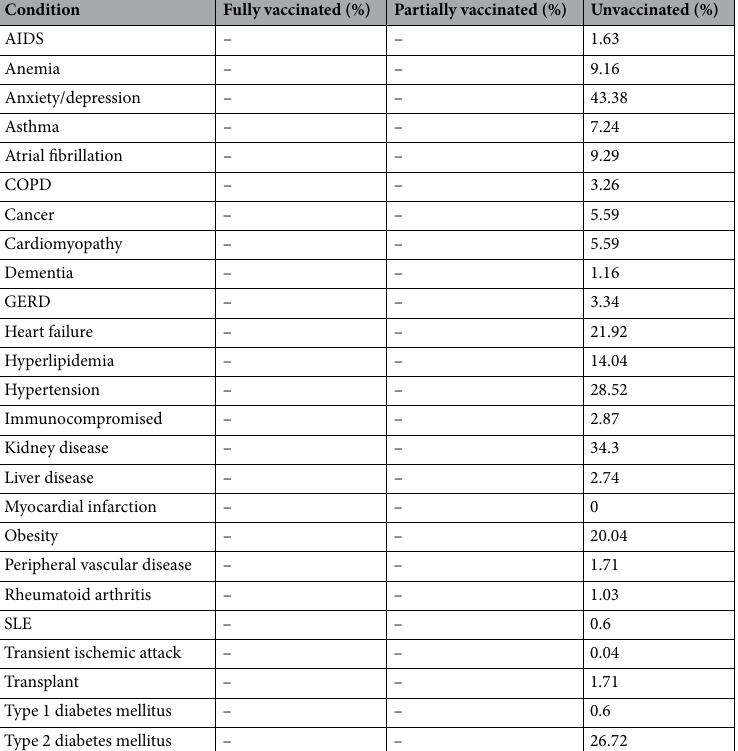
Table 5. Comorbidity information of patients with a positive SARS-CoV-2 result during the Founder variant wave (n = 2319 SARS-CoV-2 infections) expressed as frequency